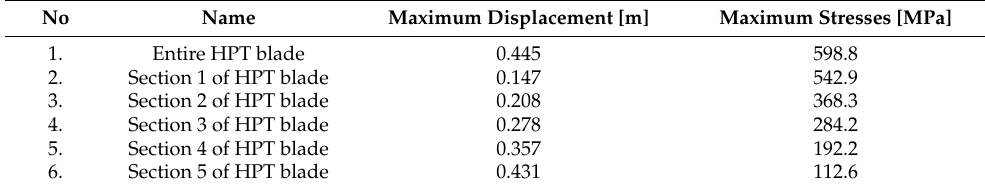
Figure 10. Position of the specific sections of the HPT blade ( a ); Equivalent stresses (von Mises) [MPa] distribution in specific sections of the HPT blade: ( b ) Section 1; ( c ) Section 2; ( d ) Section 3; ( e ) Section 4; ( f ) Section 5. Table 2. Results of numerical strength analysis of the high pressure turbine